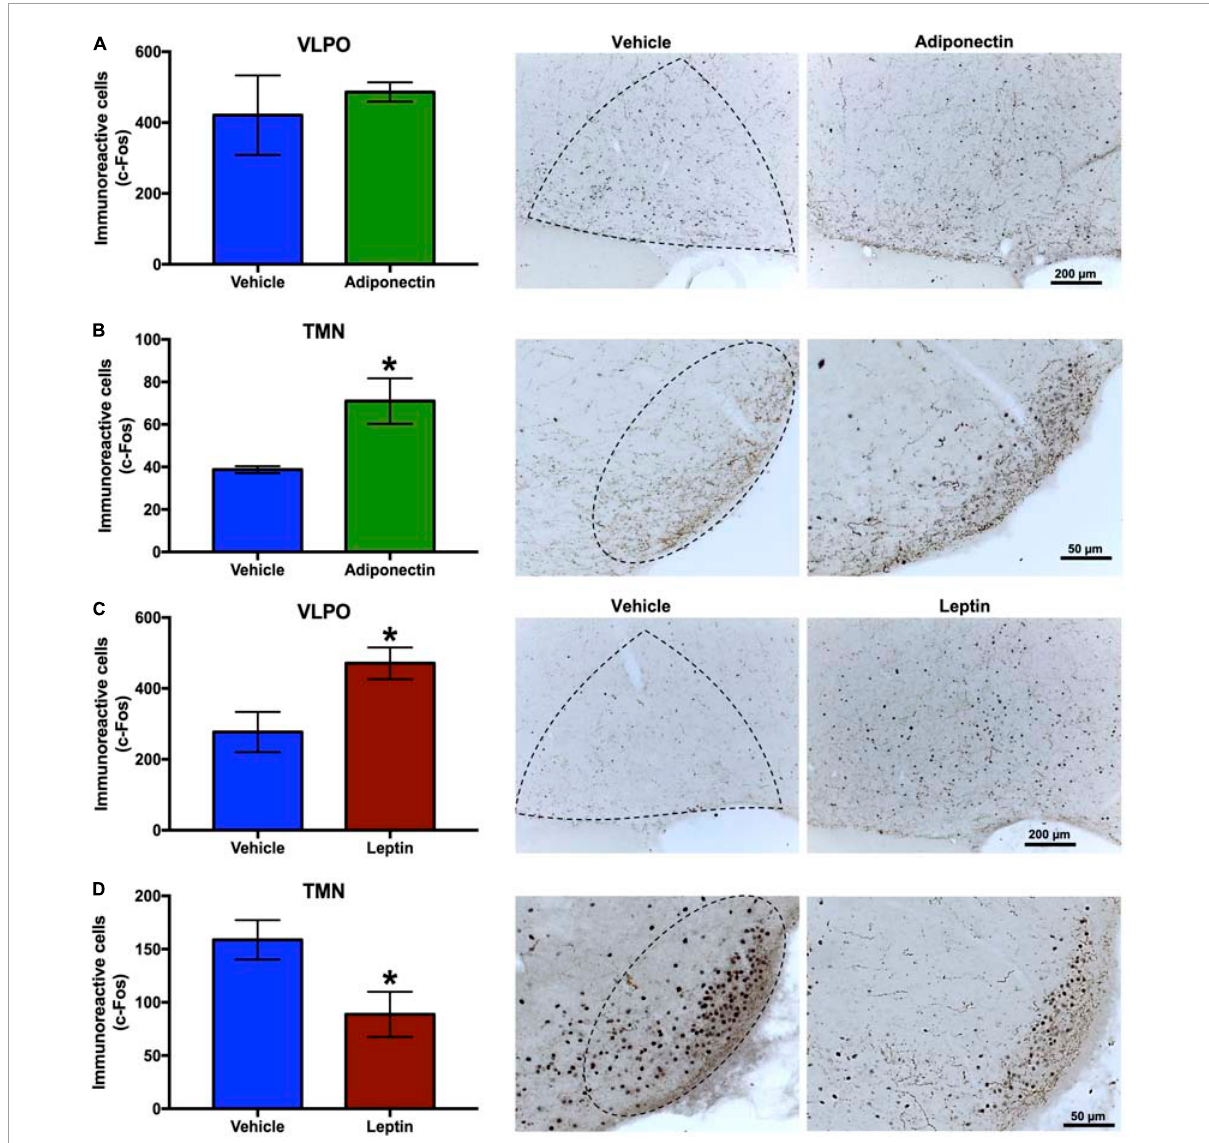
FIGURE6 c-Fos immunoreactivity in VLPO and TMN after adipokines or vehicle administration. Immunoreactive cells to c-Fos in VLPO and TMN 2 h after (A,B) adiponectin or (C,D) leptin administration, and representative images (right columns, dashed lines border the nuclei area). Adipokine vs. vehicle * P < 0.05. VLPO, ventrolateral preoptic nucleus; TMN, tuberomammillary nucleus.